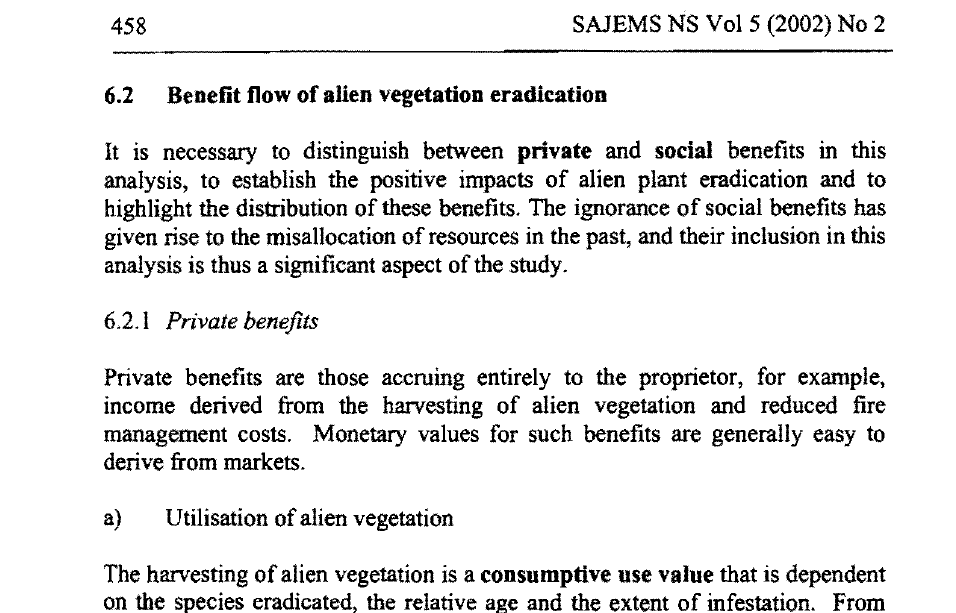
Total value (August 2001 values) of commercial forestry species located in invaded areas of study